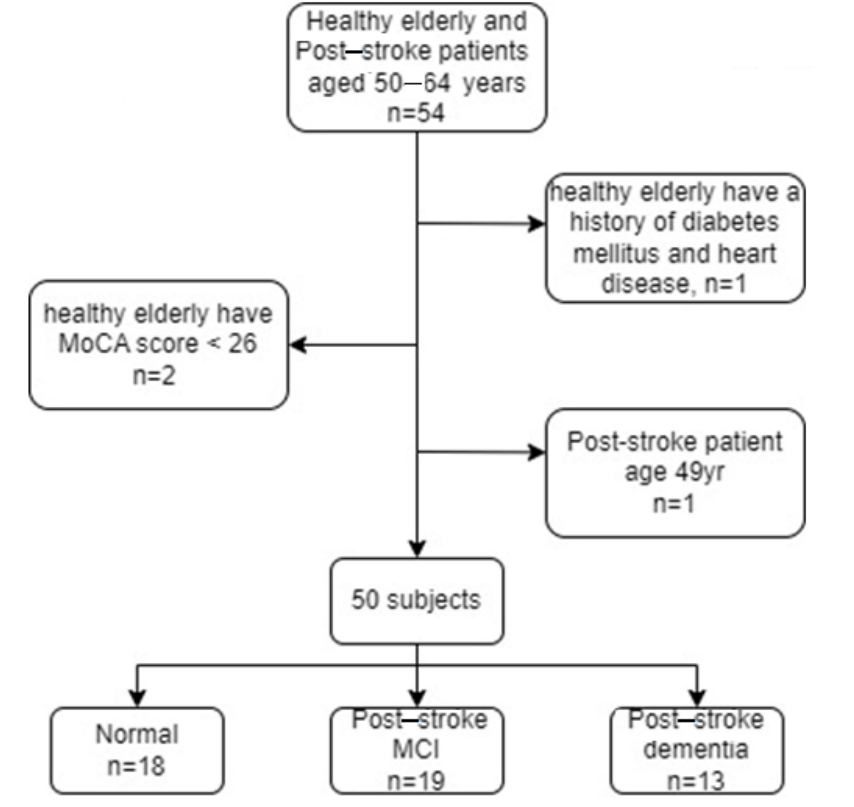
Figure 2. Summary of subject selection criteria. Table 1. Clinical data of research